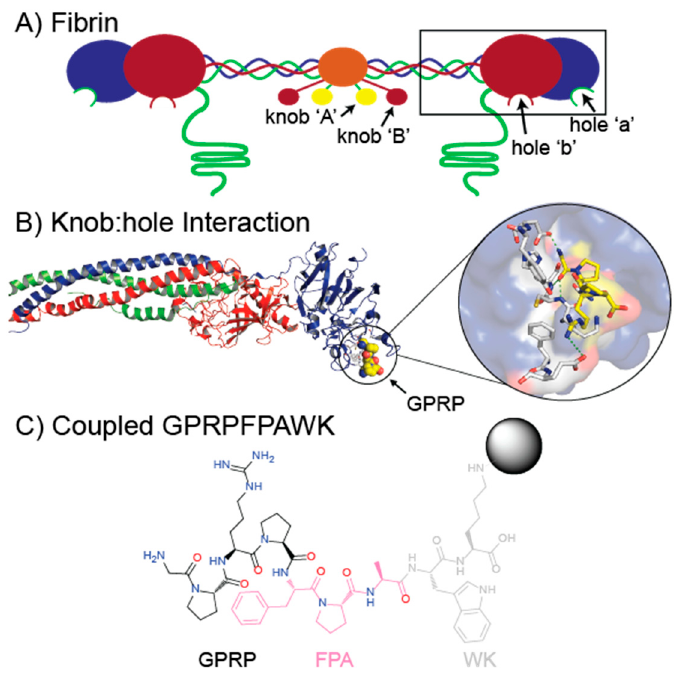
Figure 1. Cartoon model of fibrin and the binding interactions of the GPRP functional structure of knob ‘A’. ( A ) Fibrin monomer model consisting of two sets of three polypeptide chains: A α chains (green), B β chains (red), and γ chains (blue). Central E region (orange) has exposed knobs ‘A’ (yellow) and ‘B’ (red) from thrombin cleavage, while the black box highlights the distal D region containing holes ‘a’ and ‘b’. ( B ) Crystallographic structure of the fibrinogen D region (box in panel ( A ) using PDB 3GHG. Inset shows a blow-up of the knob-hole interaction between fibrinogen hole ‘a’ and knob ‘A’ mimic GPRP (yellow). ( C ) GPRPFPAWK peptide coupled with NHS-activated Sepharose highlighting knob ‘A’ mimic residues (black), fibrinogen affinity enhancing residues (pink), and other residues indirectly involved in binding fibrinogen